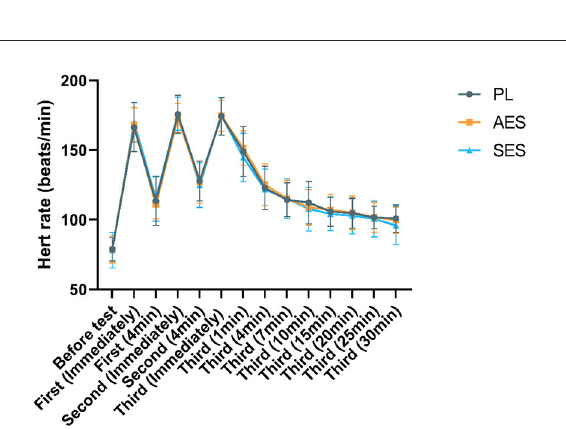
FIGURE5 HR responses during three groups of experiments. Values are means ± SD. First (N min): N minute following the first WAT; Second (N min): N minute following the second WAT; Third (N min): N minute following the third